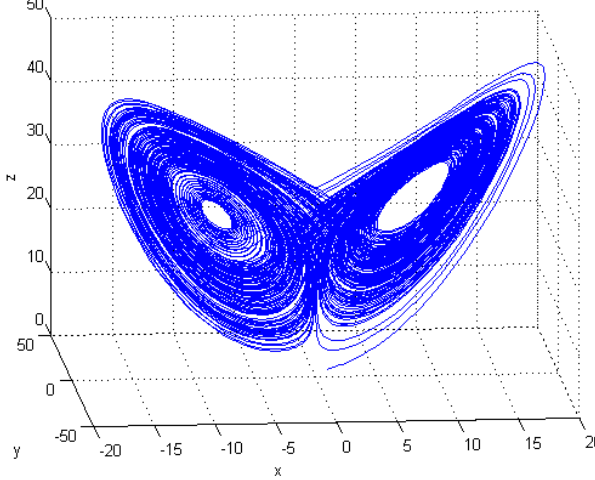
Figure 1. The Lorenz attractor, initial values x (0) = 1 , y (0) = 1 , and z (0) = 1 , discretization time step is dt = 0 . 1 time unit.